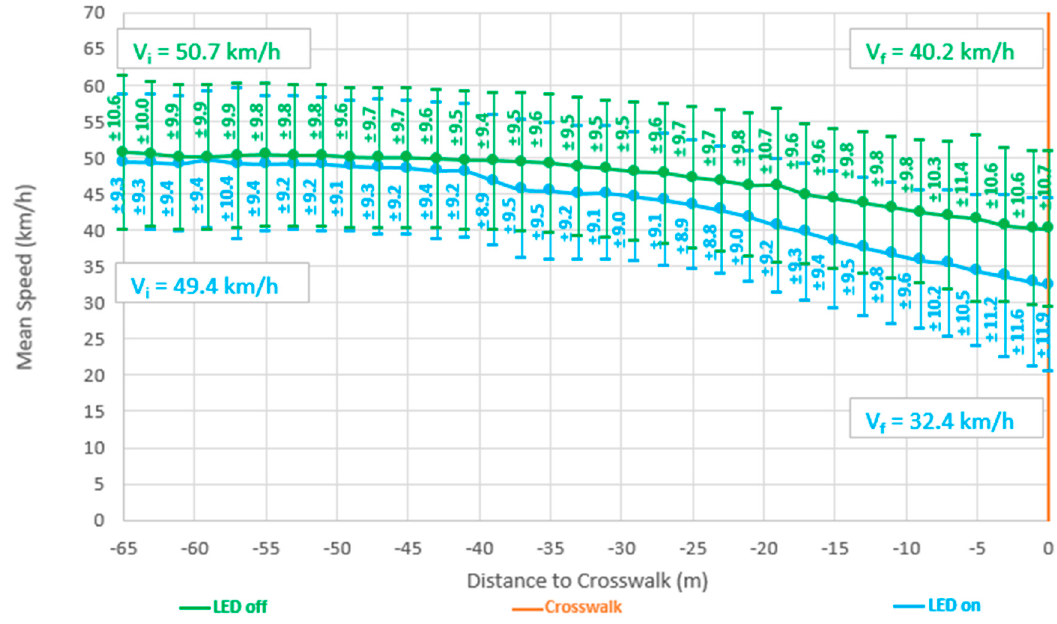
Figure 7. Mean speed profiles (with pedestrian).